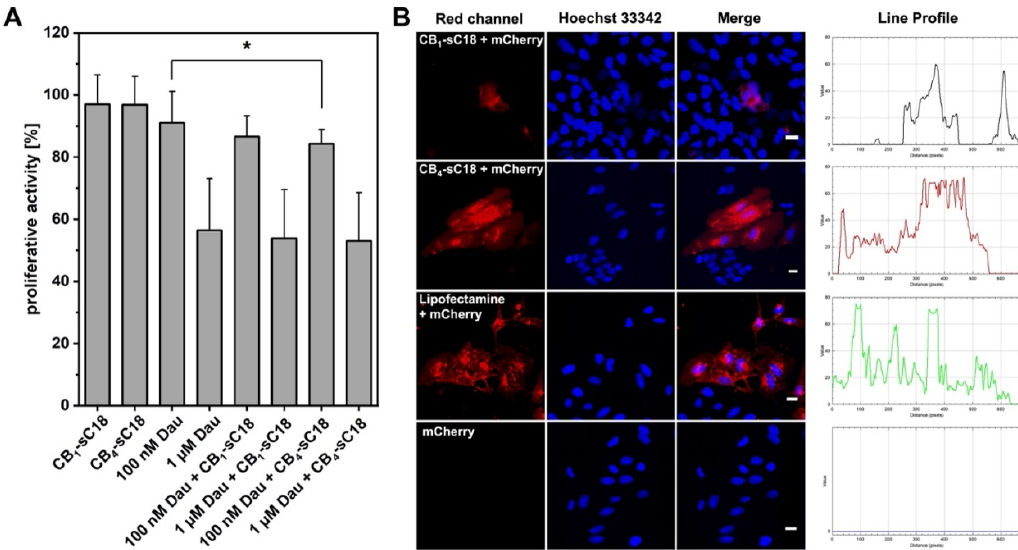
Figure 4. Cargo delivery properties of CB-sC18 conjugates. ( A ) Proliferative activity of CB-sC18 conjugates, Dau and CB-sC18/Dau mixture towards HeLa cells. Significances were determined by Student’s t-test (* p < 0.05). ( B ) Microscopic analysis of HeLa cells transfected with mCherry encoding pDNA using either CB 1 -sC18, CB4-sC18, or lipofectamine 2000, scale bar: 20 µm.